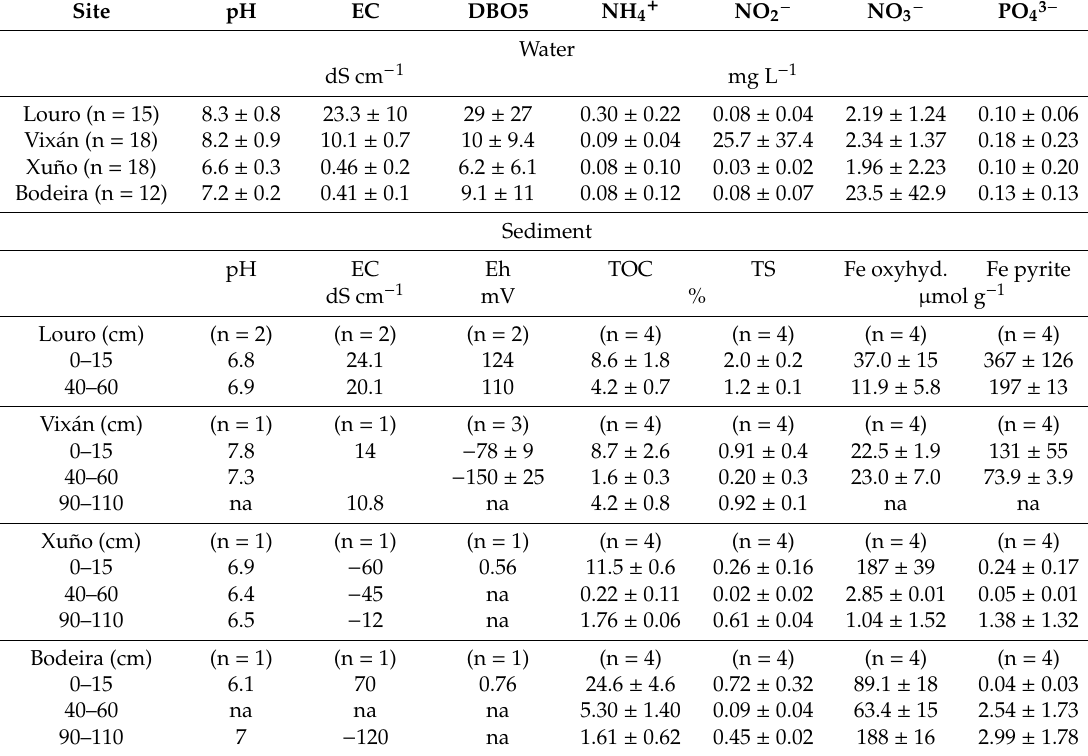
Table 2. Water and sediments physicochemical properties and composition, na: not analyzed. n: number of